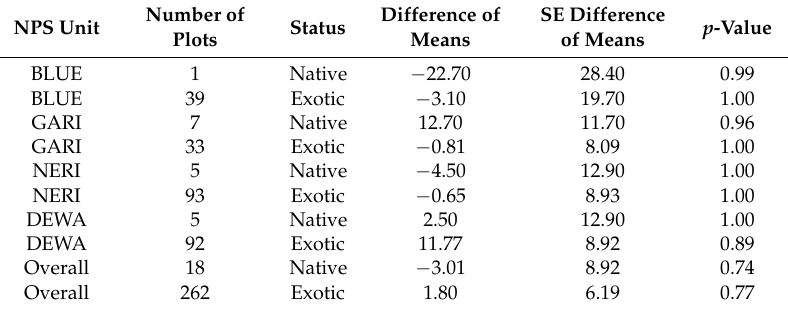
Table A2. Tukey method comparison for differences of means (disturbed–undisturbed) for average plant cover (%) for all undisturbed plots versus the disturbed plots for each NPS unit and all units combined prior to the disturbance events.